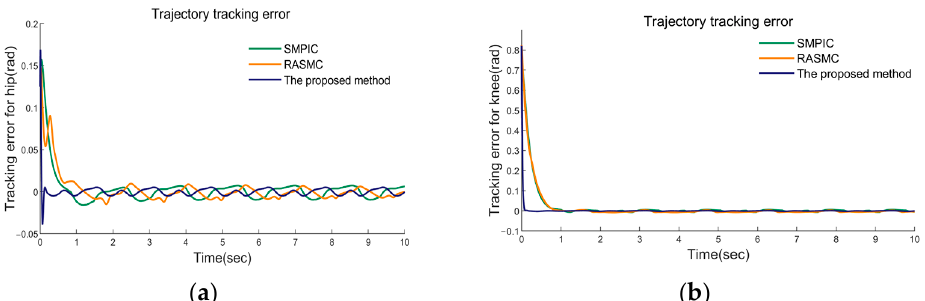
Figure 13. The tracking error of the joints. ( a ) the tracking error of θ 1 under case 2 condition; ( b ) the tracking error of θ 2 under case 2 condition.